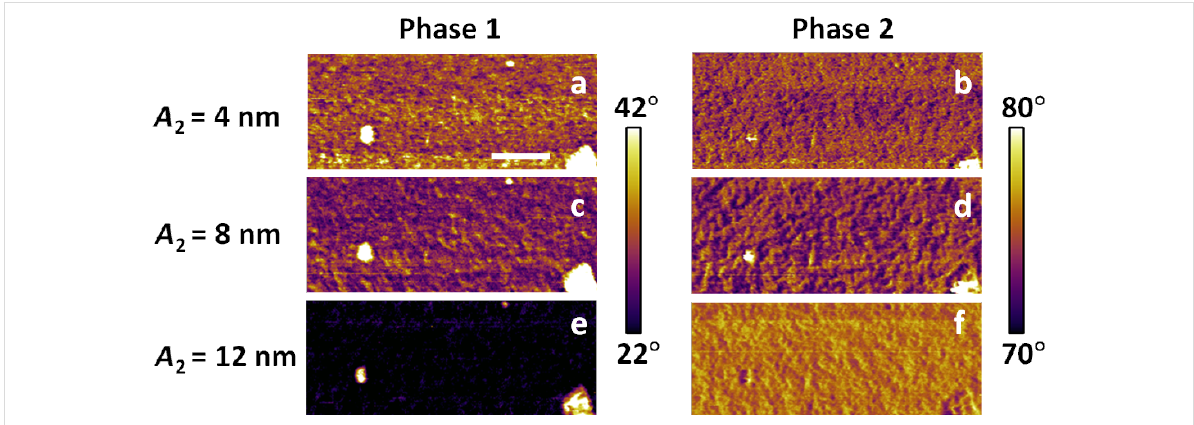
Figure 3: Bimodal experiments with varying second eigenmode amplitude for a Nafion ® membrane (the images correspond to the lower portion of those shown in Figure 1). The left and right columns provide, respectively, the phase of the first and second eigenmode. Each row is a separate experiment using the second mode free amplitude indicated on the left. The second amplitude was increased in the downward direction to increase indentation, according to Figure 2d. The first eigenmode free amplitude was 17 nm with a setpoint of 45%. The scale bar is 100